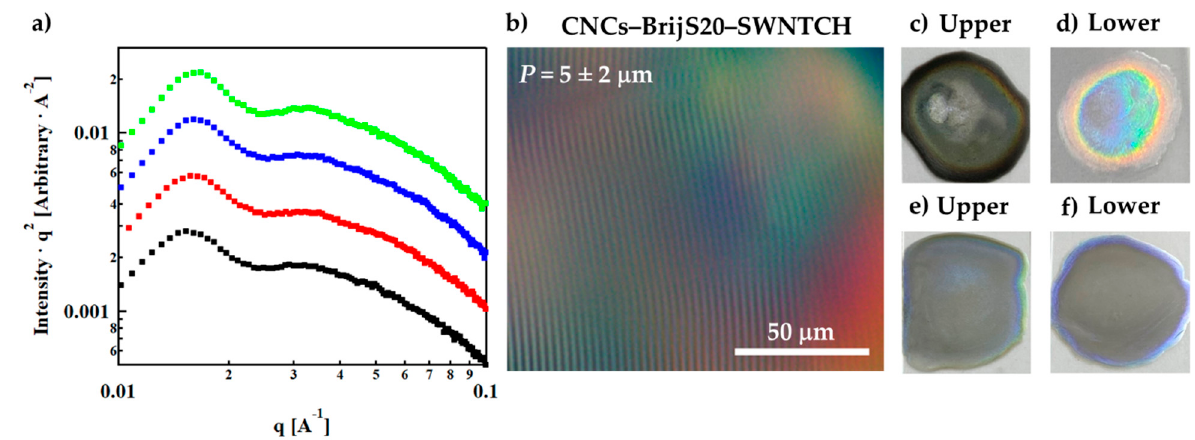
Figure 6. ( a ) SAXS Lorentz ‐ corrected intensities of the lower phase of CNCs–1 wt% F127 ( ), 6 wt% CNCs–0.5 wt% BrijS20–0.1 wt% SWNTCH ( ). The curves are shifted for better visualization. ( b ) POM image of the N* phase of 6 wt% CNCs–0.5 wt% BrijS20–0.1 wt% SWNTCH mixture. Dried films of the ( c ) upper and ( d ) lower phases of 6 wt% CNCs–0.1 wt% SWNTCH, and ( e ) upper and ( f ) lower phases of 6 wt% CNCs–0.5 wt% BrijS20–0.1 wt% SWNTCH.